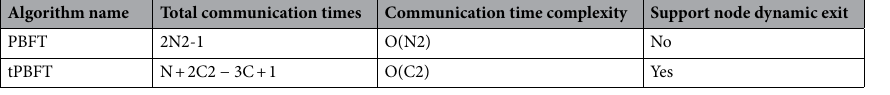
Table 2. Comparison of PBFT and tPBFT